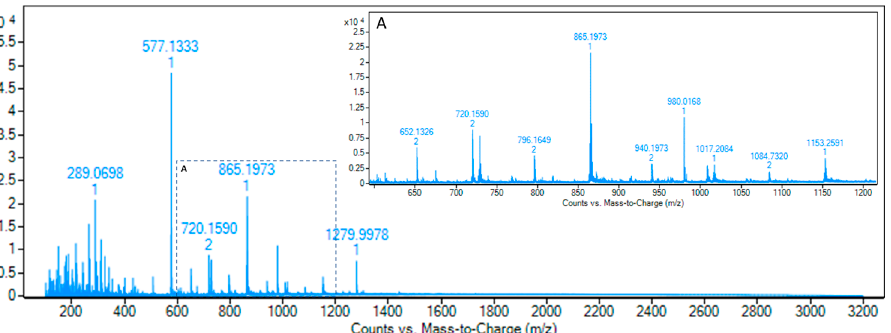
Figure 5. Representative ESI Q ‐ TOF mass spectrum of Ecovitis™. Insert A is the x ‐ axis expanded segment from 600 to 1200 m/z.